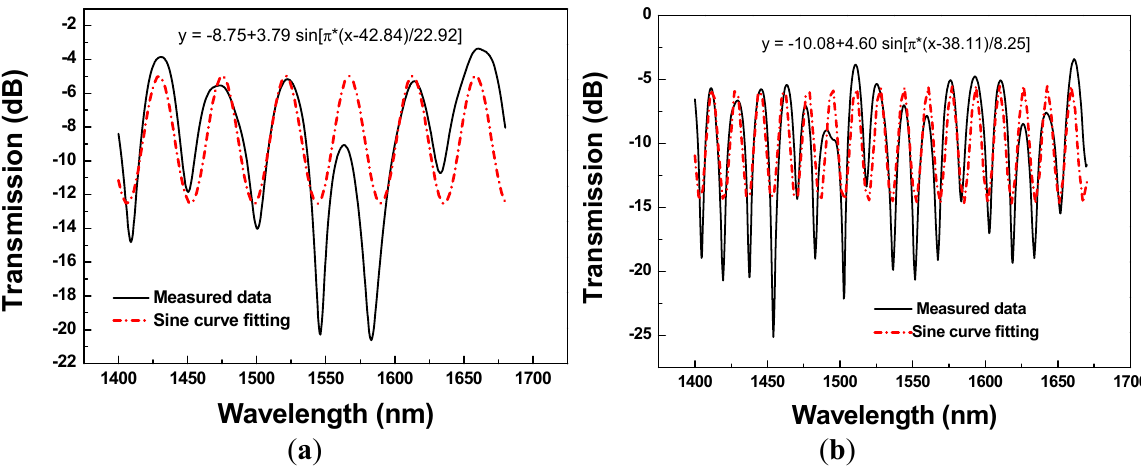
Figure 6. Plot of transmission spectra of measured data and sine curve fitting using PCF interferometers with ( a ) L = 1.34 cm and ( b ) L = 3.50 cm, respectively.